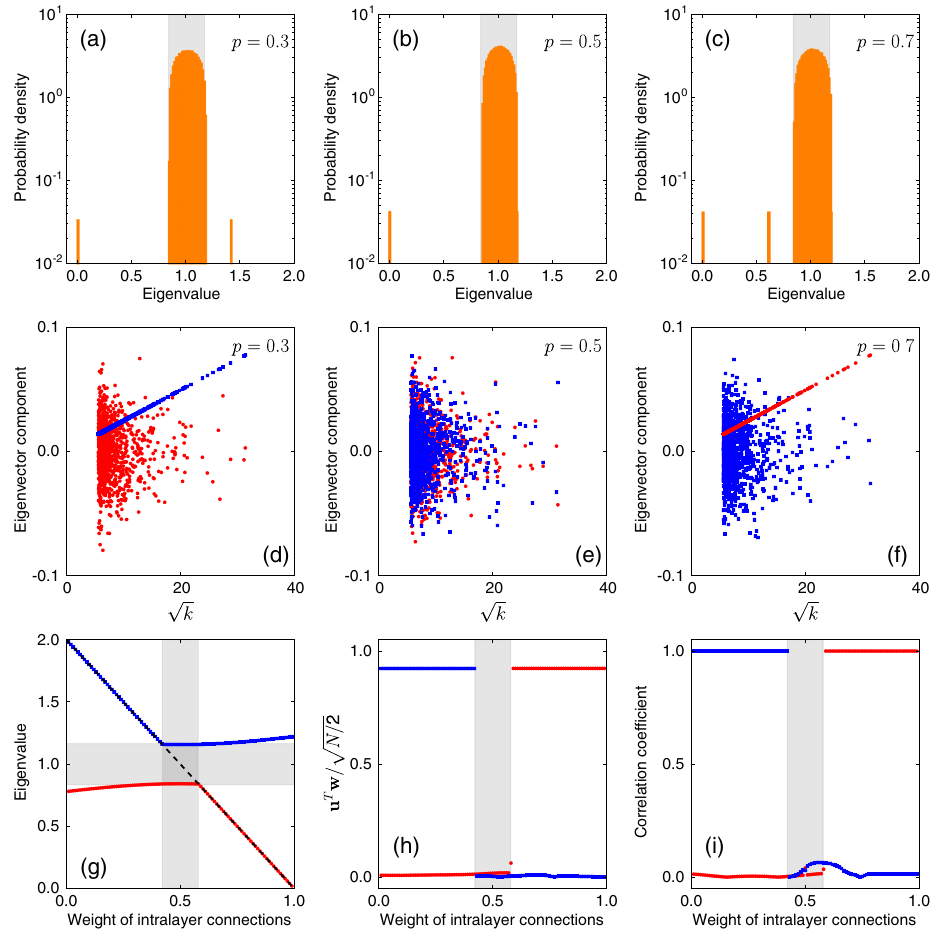
FIG. 1. Abrupt transition in interconnected networks. Spectral analysis of the normalized Laplacian L of an interconnected network composed of two network layers of size N ¼ 1024 . The degree sequence is composed of integers extracted from a power- law probability distribution with exponent γ ¼ 2 . 5 defined on the support ½ 32 ; N (cid:1) . Intra- and interlayer degree sequences are P k in k out P ð k in ; k out Þ ¼ h k 2 i . As the weight of the intralayer connections perfectly aligned so that the correlation term reads ξ ¼ k in ;k out p varies, the system explores different regimes that are clearly visible from the spectrum of L . (a) For p ¼ 0 . 3 , only the largest eigenvalue ν 2 N is well separated from the rest of the spectrum. The system is said to be in the “ bipartite ” regime ( B phase). (b) For p ¼ 0 . 5 , there are no detached eigenvalues. The system is in the “ indistinguishable ” regime ( I phase). (c) For p ¼ 0 . 7 , the second- smallest eigenvalue ν 2 is well separated for the rest of the spectrum. The system is in the “ decoupled ” regime ( D phase). (d) In the B phase, the components of the largest eigenvector w ffiffiffi 2 N corresponding to a single network layer (blue squares) are linearly p k correlated with the square root of the respective node degrees , while those of the second-smallest eigenvector w 2 (red circles) ffiffiffi p k are not. (e) In the I phase, there is no correlation between the components of w 2 N ( w 2 ) and . (f) In the D phase, the components ffiffiffi p k of the second-smallest eigenvector w 2 are linearly correlated with , while the components of w 2 N are not. (g) The transition points p − c ≃ 0 . 42 and p þ c ≃ 0 . 58 (delimiting the vertical gray band) between the different regimes correspond to the points in which our prediction [Eq. (5), dashed black line] enters the continuous band of the spectrum [Eq. (4), horizontal gray band]. Red circles refer to ν 2 , while blue squares refer to ν 2 N . (h) The sums of the components of w 2 (red circles) and w 2 N (blue squares) corresponding to nodes of a single network layer can be used as an order parameter to monitor the transition between the different regimes. ( u is the vector whose components are all equal to 1.) (i) As noted above, in the D phase ( B phase), the components of w 2 ( w 2 N ) are perfectly correlated with the square root of the node